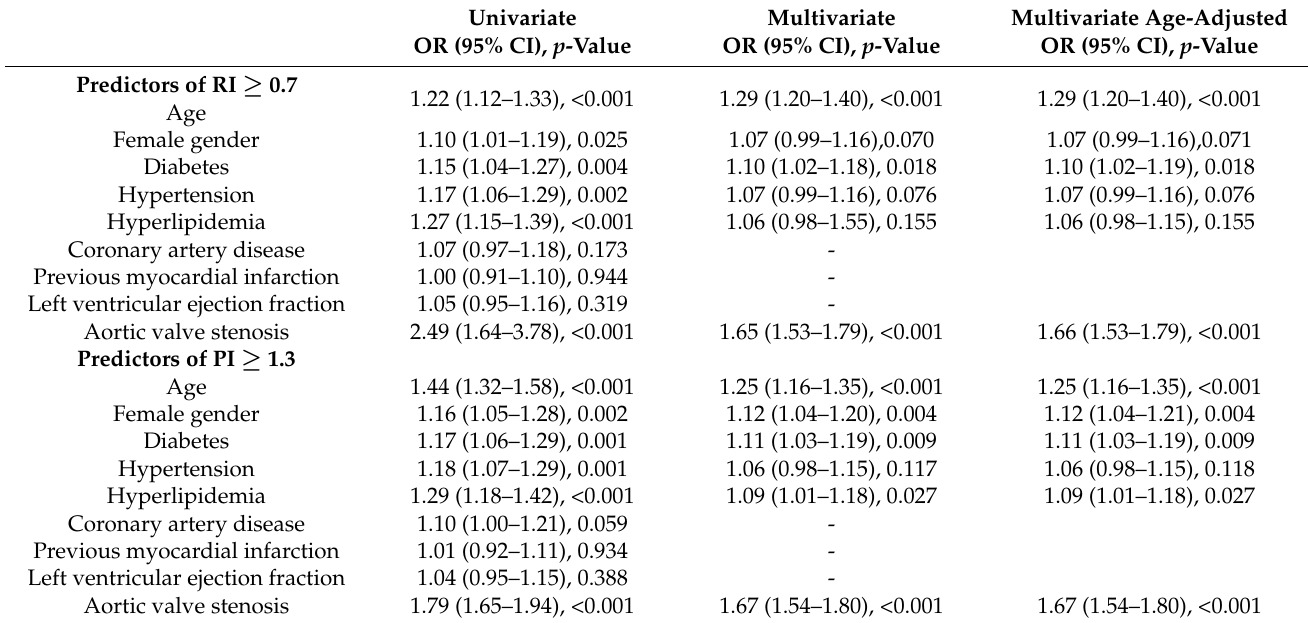
Table 2. Factors associated with increased arterial resistance.